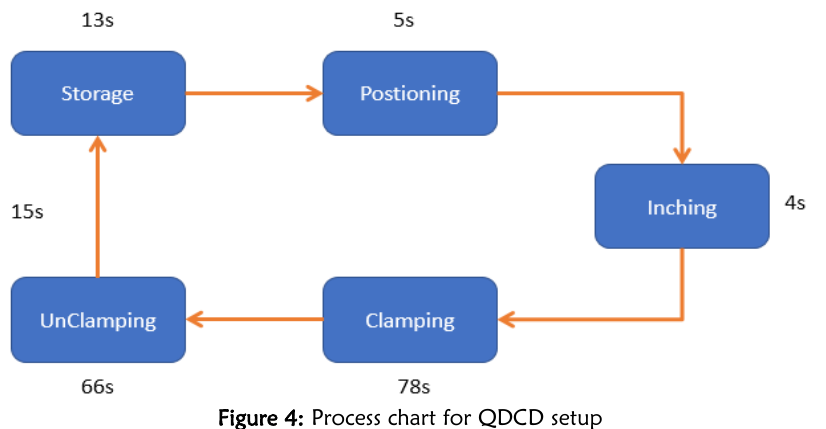
Figure 4: Process chart for QDCD